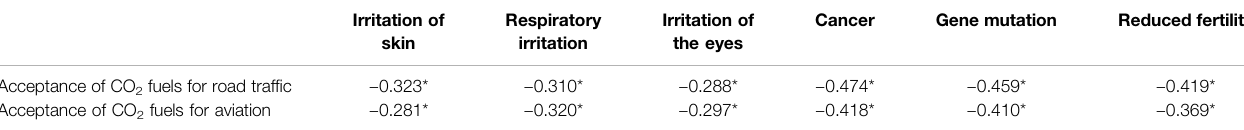
TABLE 5 | Bivariate correlations of acceptance of CO 2 -based fuels and perceived frequency of health consequences of CO 2 -based fuels compared to conventional fuels. Irritation of